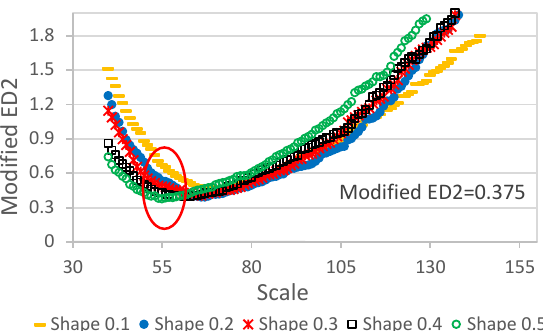
Figure 5 . Modified ED2 computed by using AssesSeg for MRS outputs from Deimos-2 MS ATCOR orthoimage.